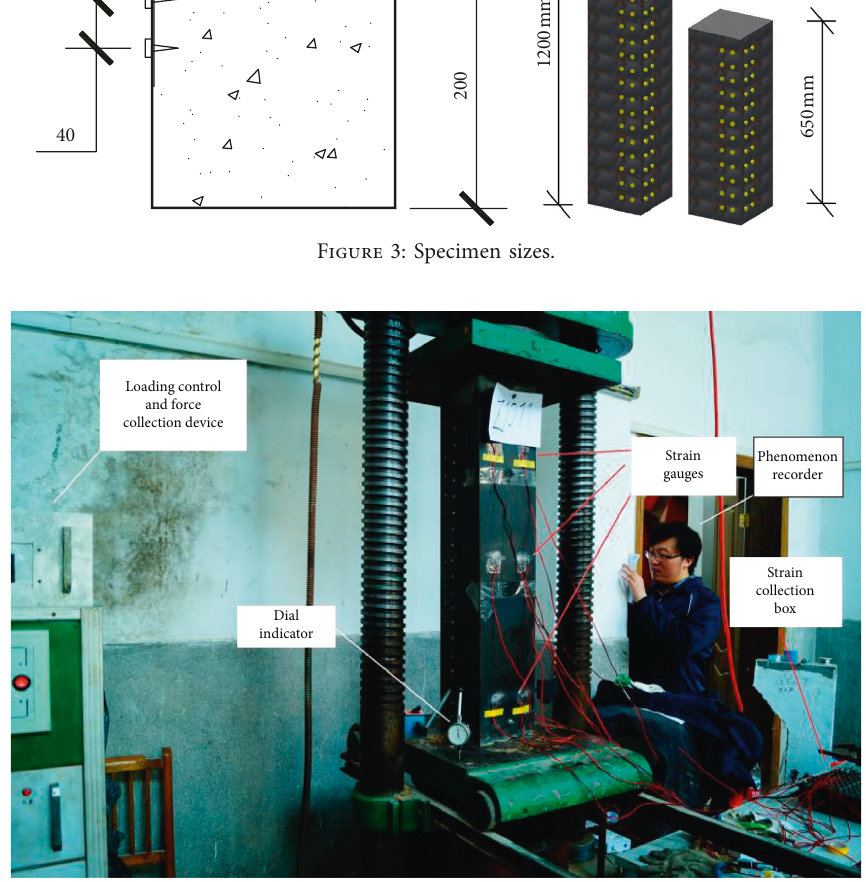
Figure 4: Experimental devices.